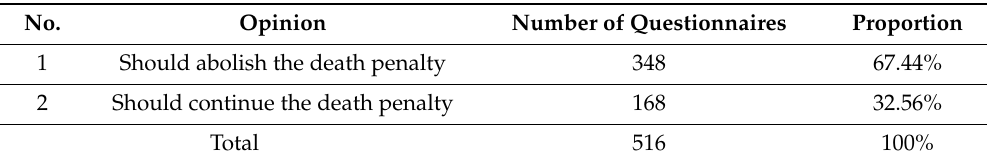
Table 6. Opinion on the death penalty of the second group. (The second group consisted of people who were randomly selected from the law and educational communities, including: (1) Law students, (2) o ffi cial who work in state agencies of the judicial system, such as police, procuracy, and court o ffi cials, as well as from departments of judgment and execution, (3) people who work in law firms, (4) professors, and (5) from ten families who have had relatives sentenced to death by the death penalty after committing a particularly serious crime, which is defined in the Penal Code. The analysis of 516